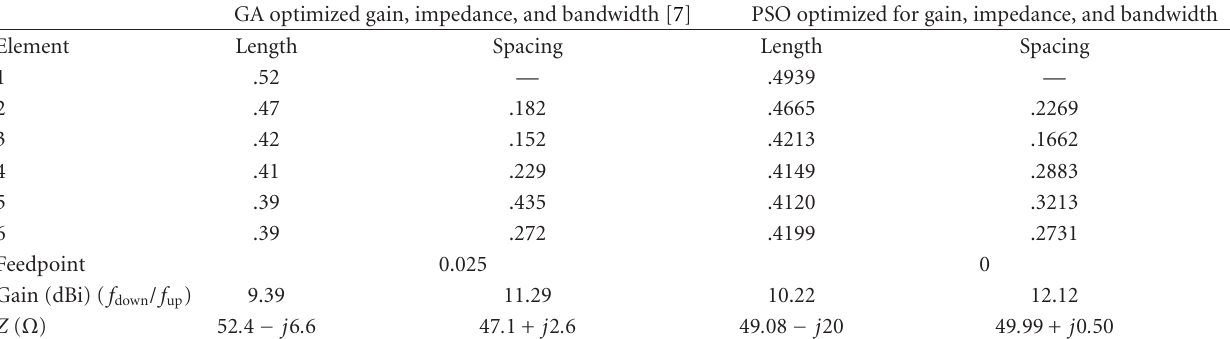
Table 2: Length, spacing, and performance comparisons. The central frequency is 300mHz. The radius of elements is 0.003369 λ . Length and spacing are also in terms of wavelength.